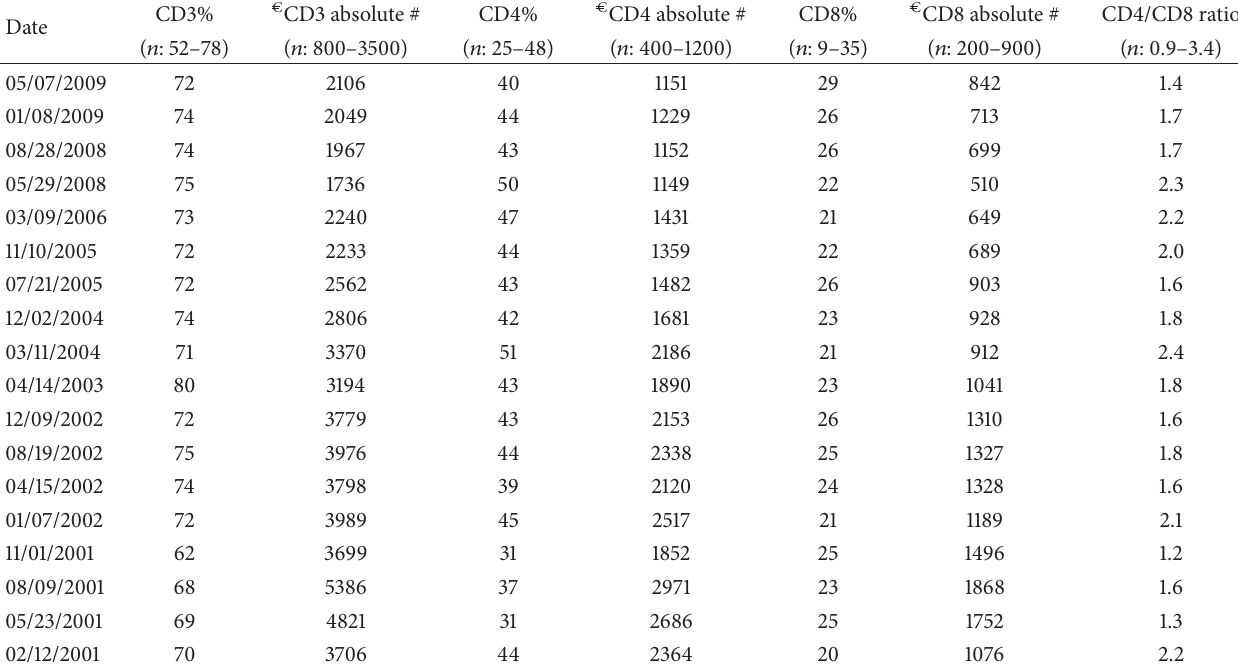
Table 1: Clinical laboratory results: CD4/CD8 values.